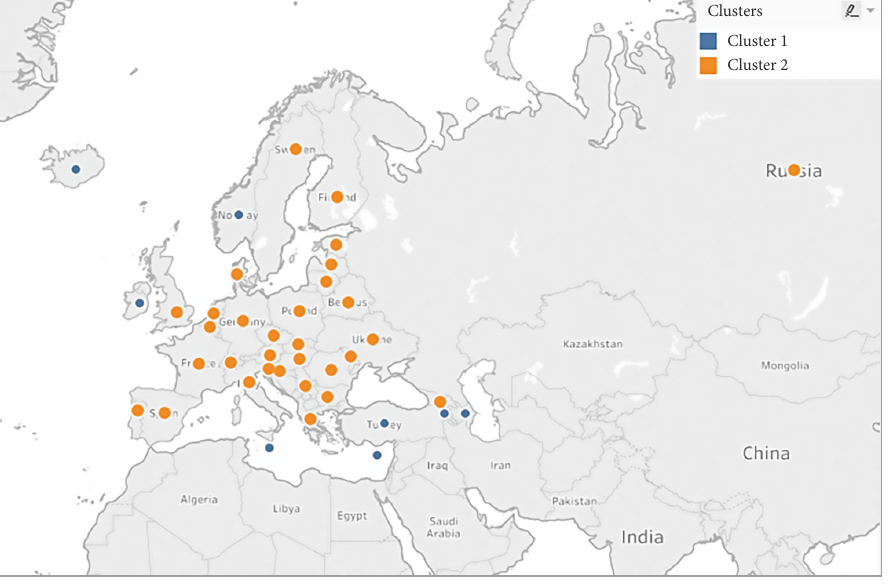
Figure 6. The two clusters in the case of the component, population aging and mortality (source: authors’ computation using Tableau Public